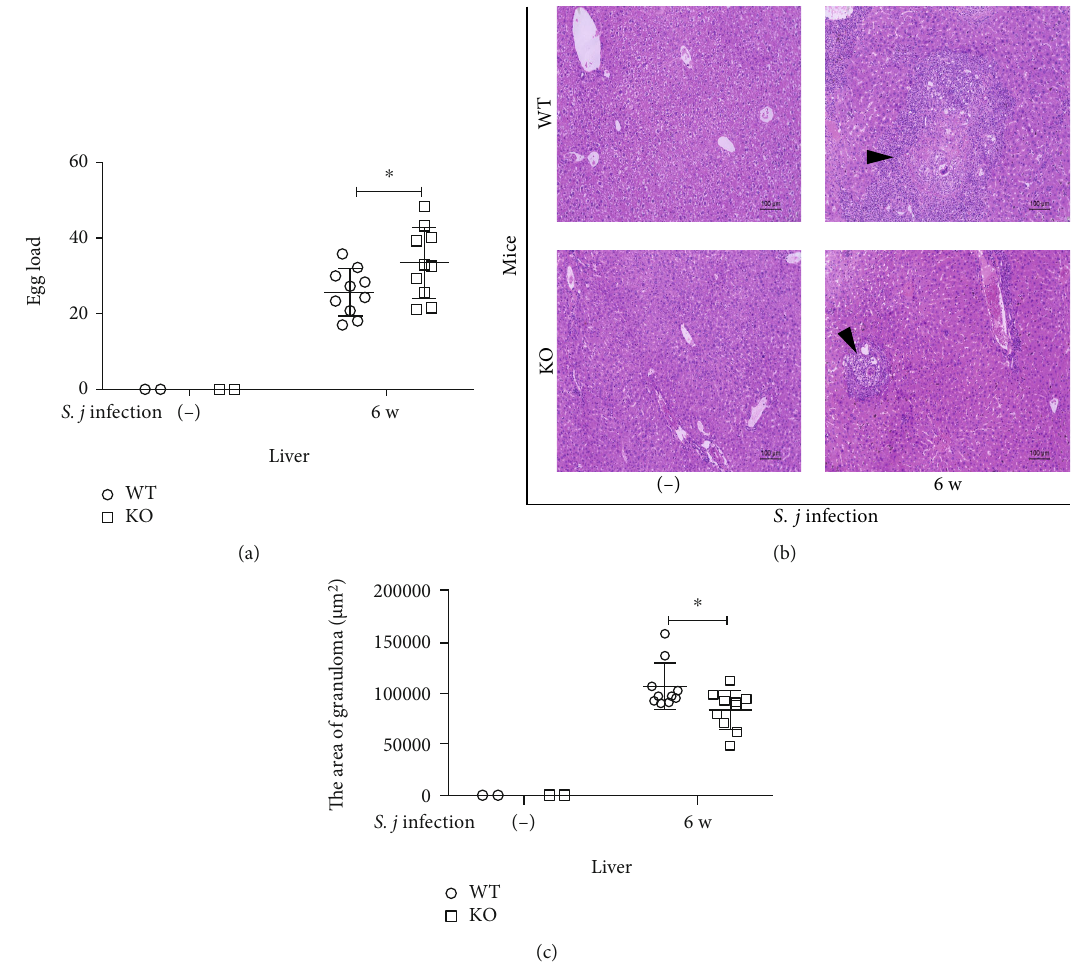
Figure 2: E ff ect of USP21 on S. japonicum eggs in infected KO mice. (a – c) The livers were harvested from the mice on the 42 nd day after the infection for HE staining, and the number of eggs was counted under the microscope ( n = 2 from the uninfected group and n = 10 from the infected group). (a) Statistical graph of the eggs in the livers of the WT-INF group and the KO-INF group (the data are presented as the means ± SD , ∗ p = 0 : 043 ). (b) Representative images of HE staining in the livers of WT-INF and KO-INF groups (original magni fi cation: 100x). The arrows indicate the granulomas. (c) Comparison of the liver egg granuloma areas between the WT-INF and KO-INF groups. The data are presented as the means ± SD , ∗ p = 0 : 022